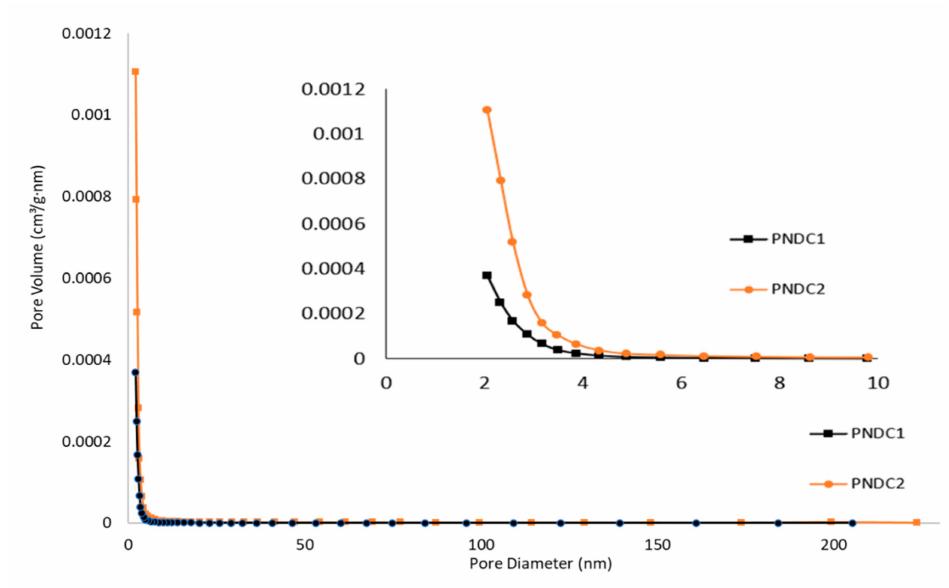
Figure 1. Pore size distribution plots for PNDC1 and PNDC2. Table 1. Surface area and pore volume of PNDC1 and PNDC2 as obtained by Brunauer–Emmet–Teller (BET) analysis.